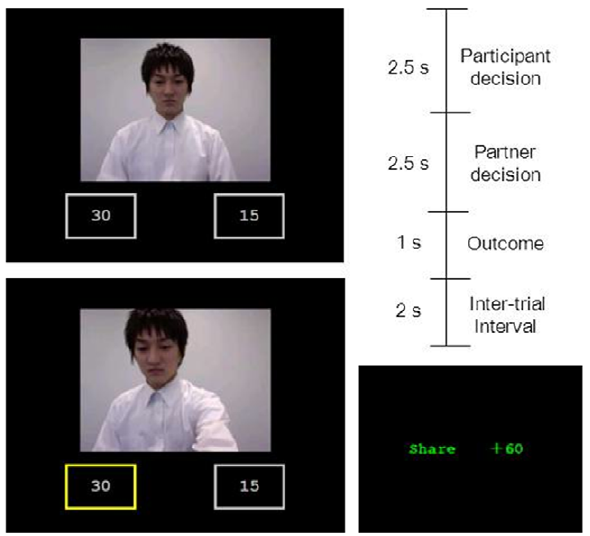
Figure 1. Experimental design of partner judgments. (A) The scale for likability and trustworthiness. (B) The scale for perceived integrity. The parson depicted in the photograph has given written informed consent, as outlined in the PLoS consent form, to publication of his photograph.